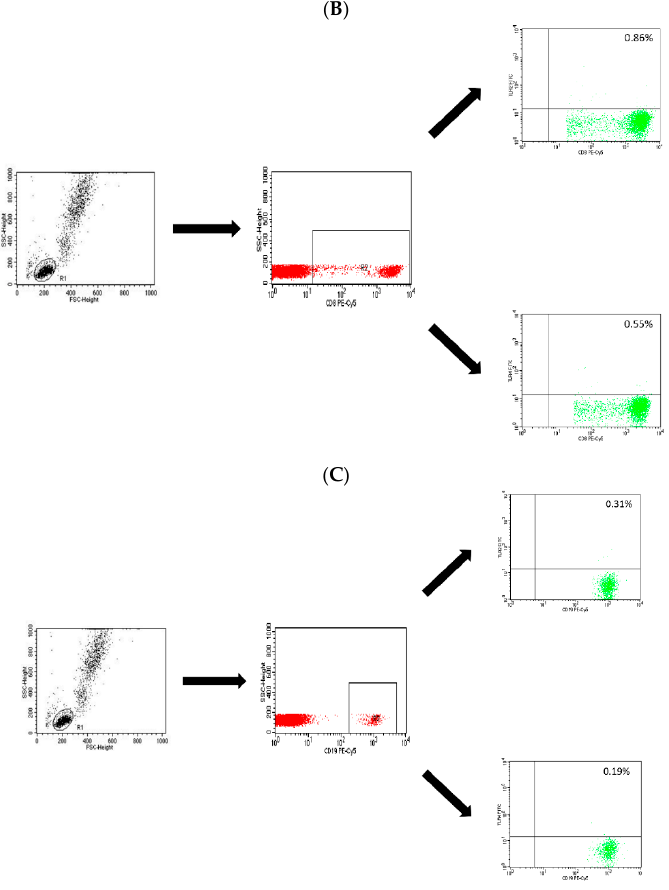
Figure 17. Dot-plots showing the percentage of T CD4+/TLR-2+ cells and T CD4+/TLR-4+ cells ( A ), CD8+/TLR-2+ T cells and CD8+/TLR-4+ T cells ( B ) and CD19+/TLR-2+ B cells and CD19+/TLR-4+ B CD8 +/ TLR-2 + T cells and CD8 +/ TLR-4 + T cells ( B ) and CD19 +/ TLR-2 + B cells and CD19 +/ TLR-4 + cells ( C ). B cells ( C